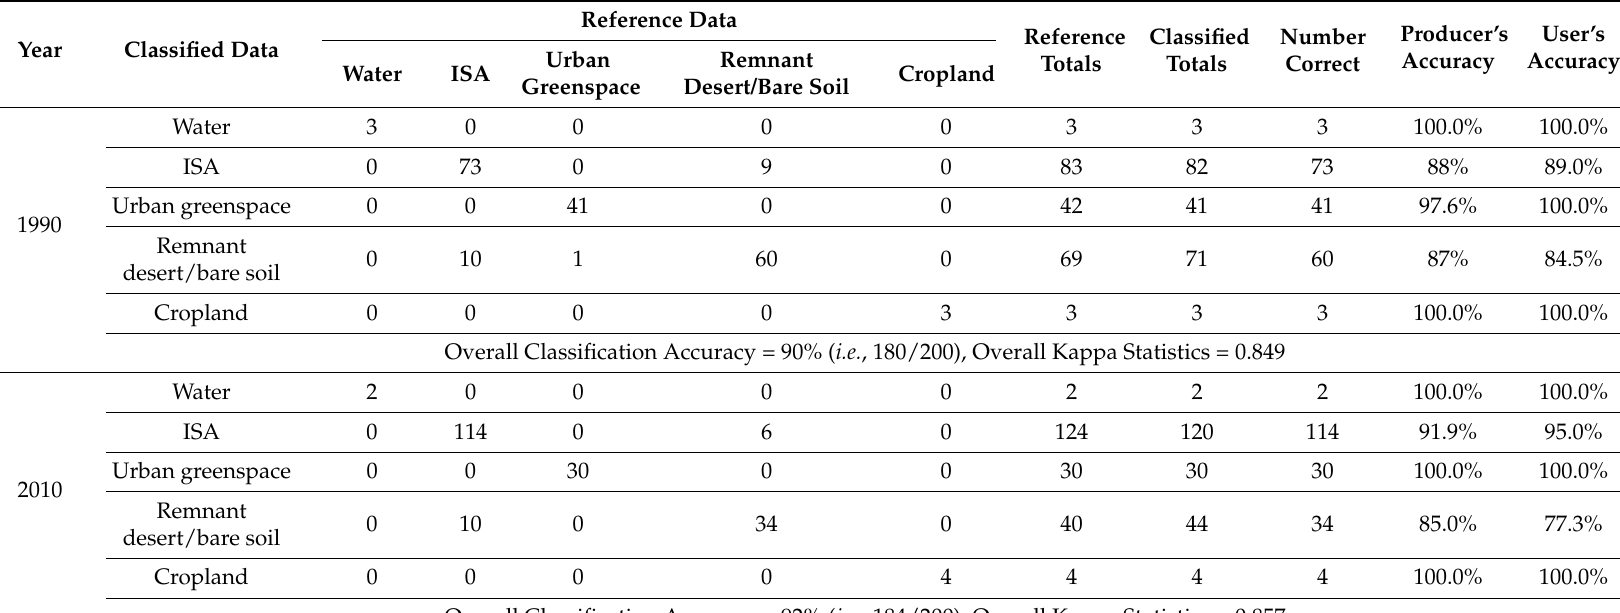
Table 1. Accuracy assessment of urban land cover classification results of Urumqi in 1990 and 2010.